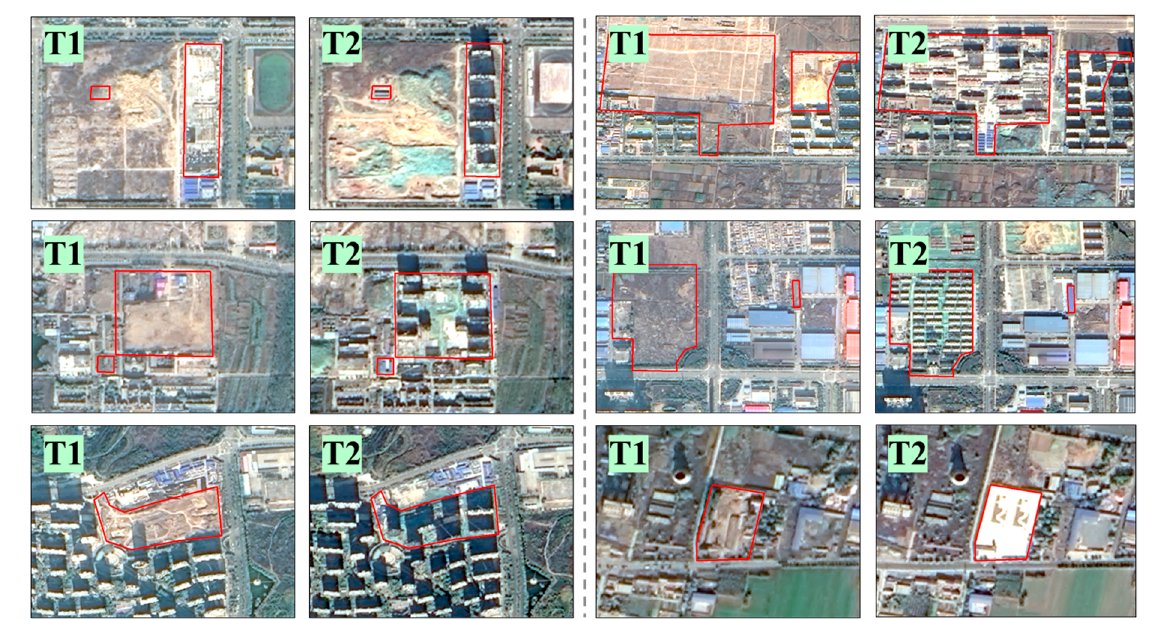
Figure 4. Labeled NCBAs. The areas surrounded by red polygons are marked as NCBAs. T1 and T2 represent pre-tem- poral and post-temporal images.